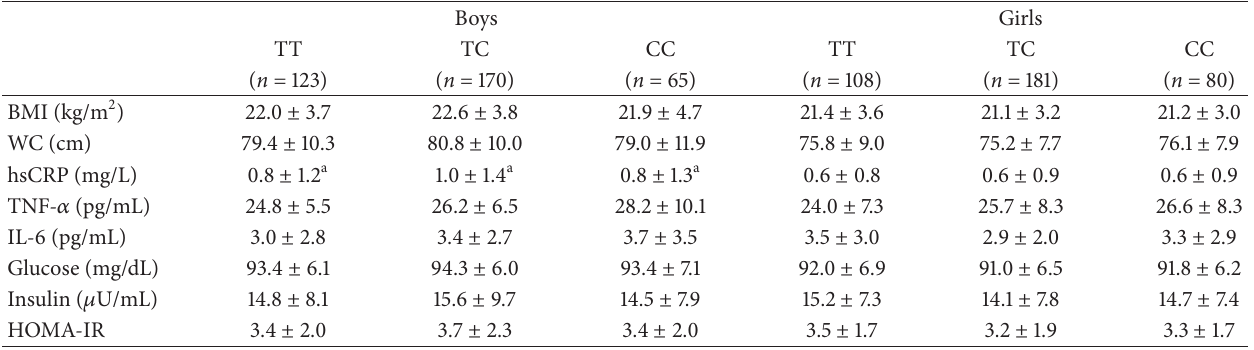
Table 3: Anthropometric and biochemical data with different AXL rs4802113 genotypes among boys and girls. Boys